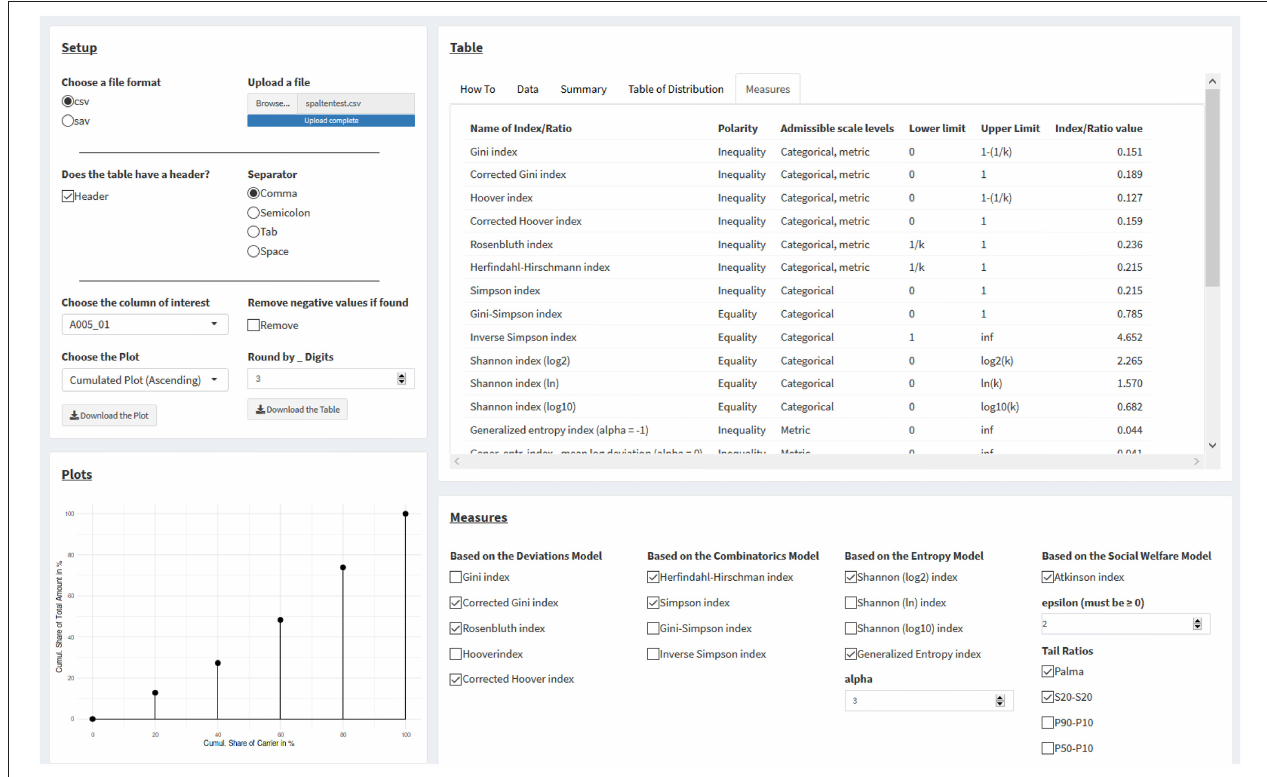
FIGURE 3 | Calculating statistical measures of inequality from one’s own datasets. See main text for details.